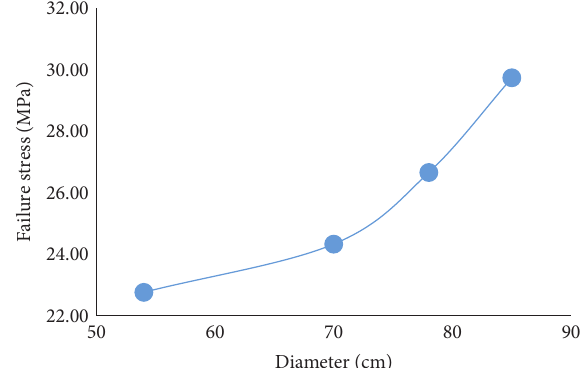
Figure 13: The curve of mean compressive failure stresses as a function of diameter in radial